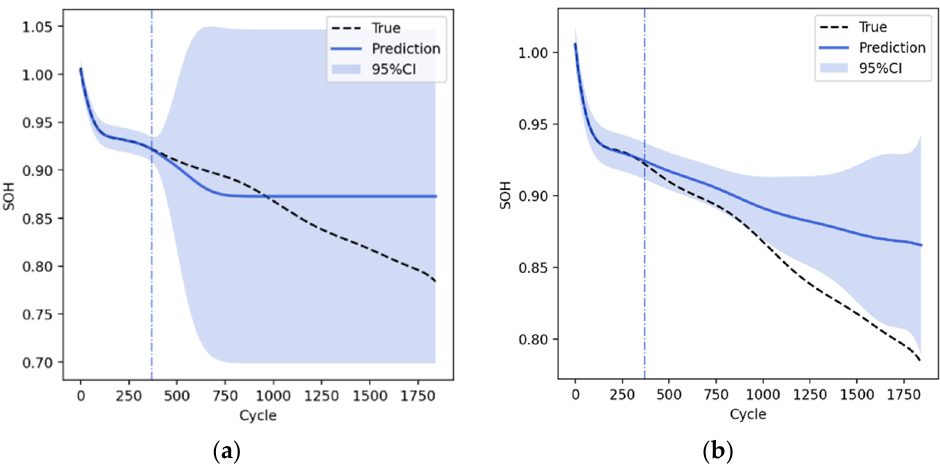
Figure 5. SOH prediction of the battery pack based on the SOGPR with different HIs: ( a ) only using the cycle number as the HI; ( b ) using the cycle number and stdQ as the